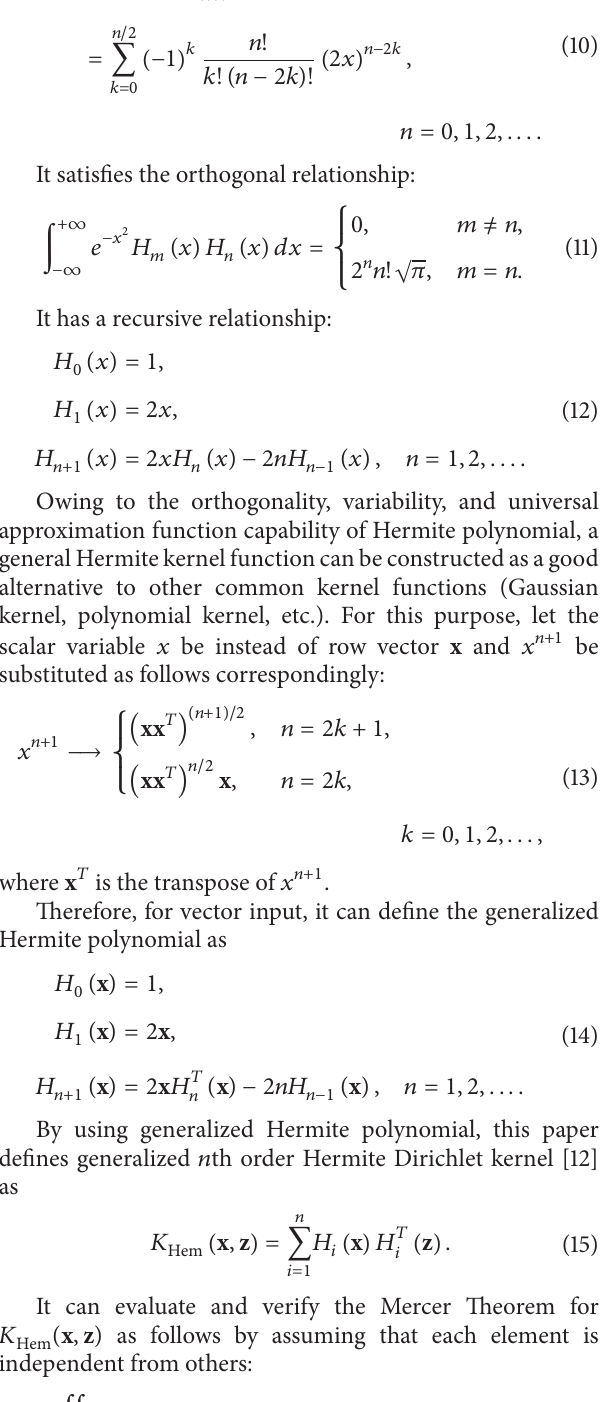
of kernel function 𝐾 Tri ( x , z ) is set to retain more distance similarity information of sample data; in addition, its com- putational cost is very